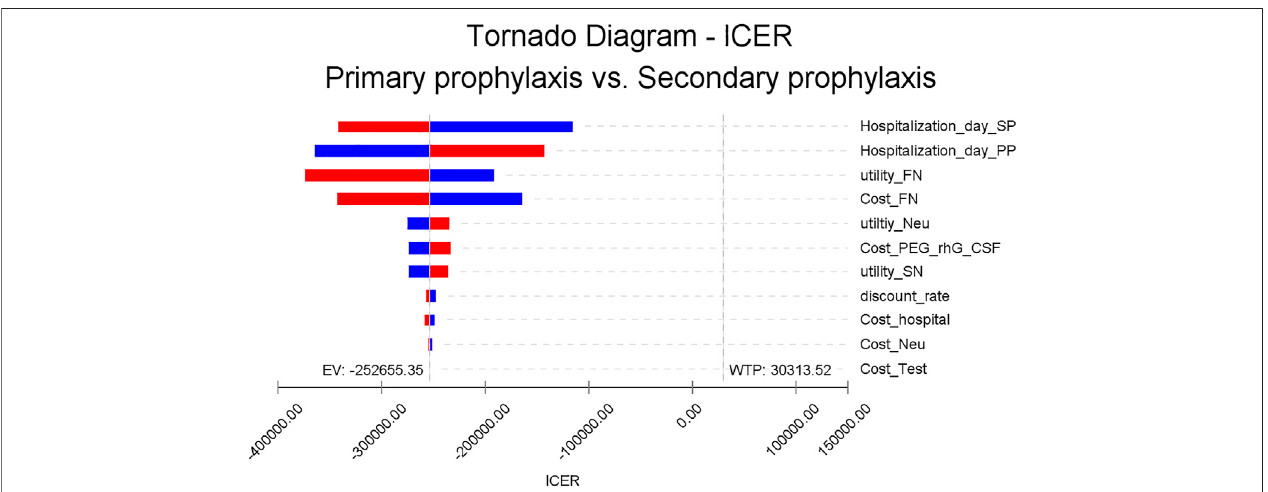
FIGURE 2 | One-way sensitivity analysis. This diagram shows incremental cost-effectiveness ratio (ICER) of PP vs SP for different model input parameters. PEG- rhG-CSF, PEGylated recombinant human granulocyte – stimulating factor; FN, febrile neutropenia; SN, severe neutropenia; PP, primary prophylaxis; SP, secondary prophylaxis; Neu, neutropenia.